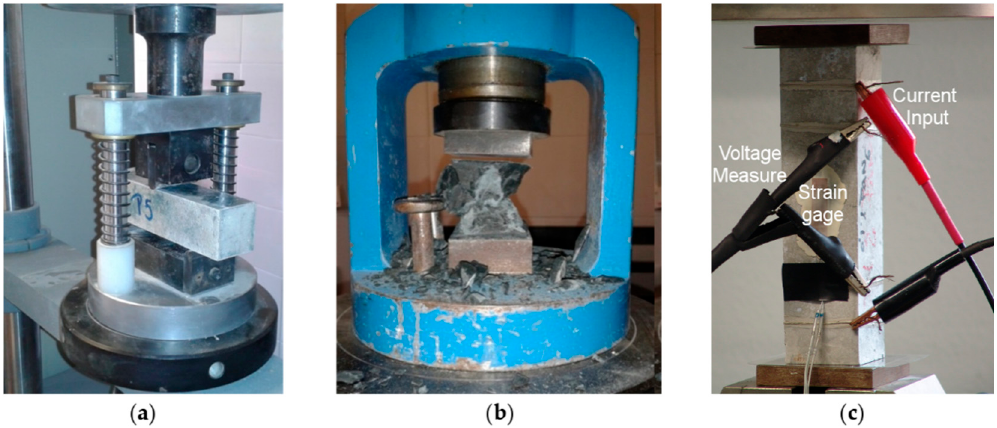
Figure 1. Experimental setup for mechanical strength tests: ( a ) Bending strength; ( b ) Compressive strength; and ( c ) electrical resistivity measures and strain sensing tests.